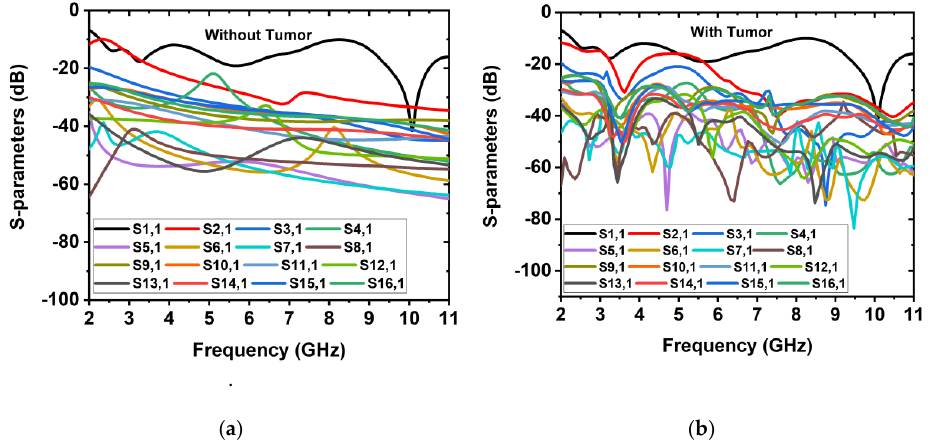
Figure 13. S-parameters of the arrays setup: ( a ) Without the presence of tumor; ( b ) With the presence of tumor inside breast phantom.